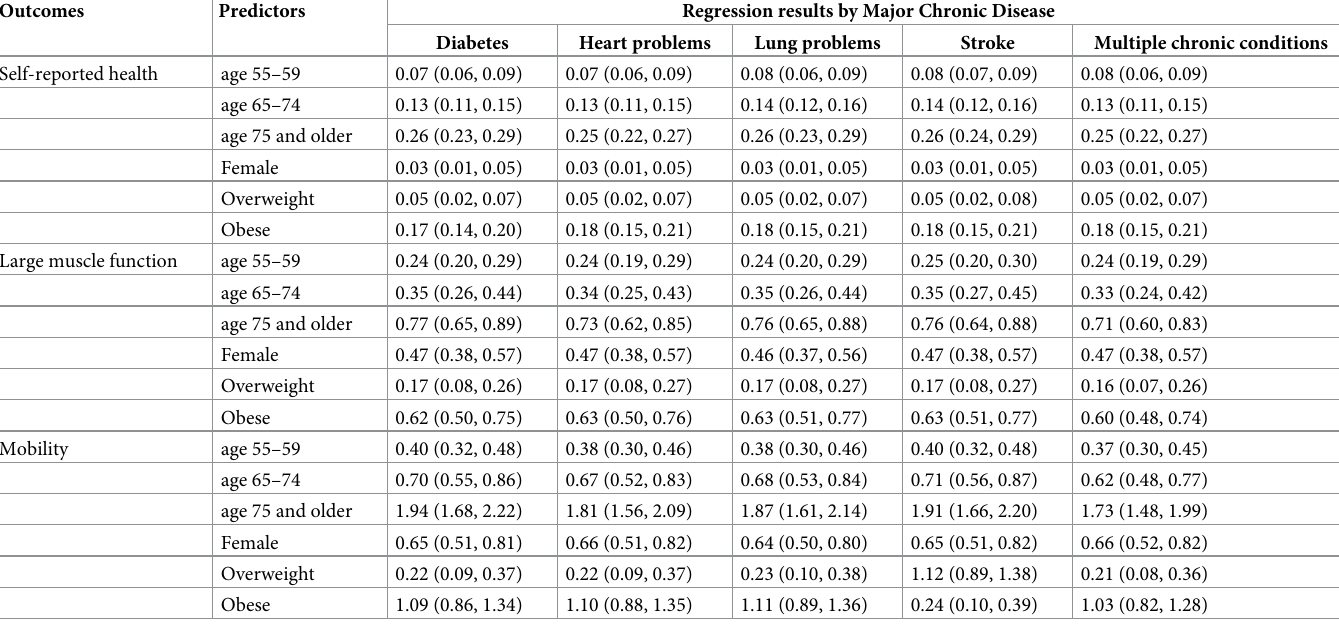
Table 4. Relative differences in scores of self-reported health, large muscle function, and mobility by age, sex, and body mass index by single and multiple chronic conditions for diabetes, heart problems, lung problems, and stroke.